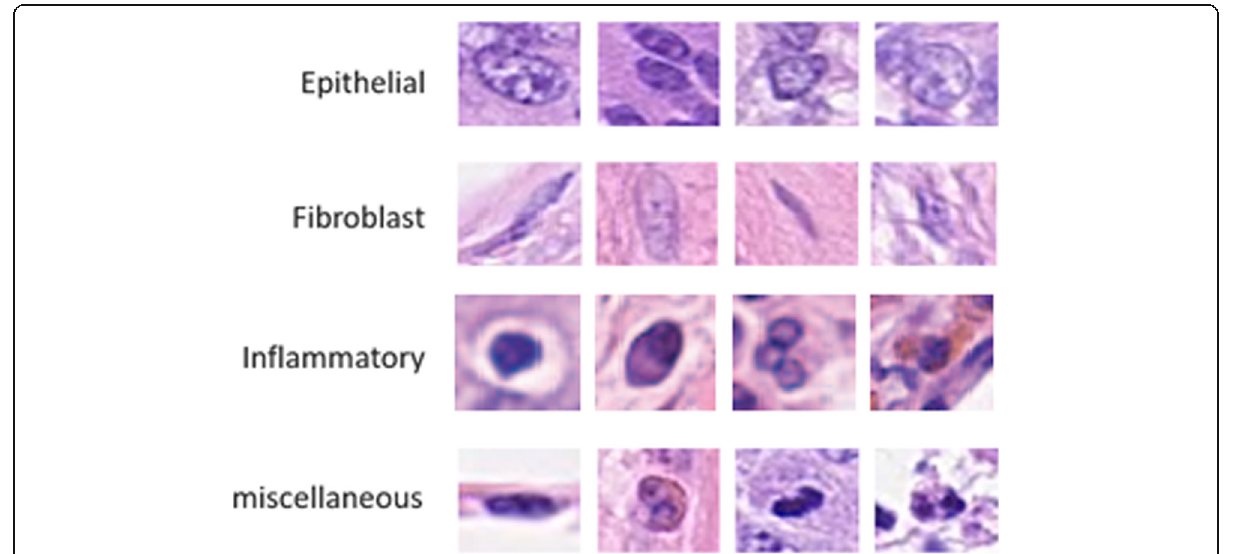
Fig. 7 Randomly selected patches for four different types of nuclei of routine colon cancer